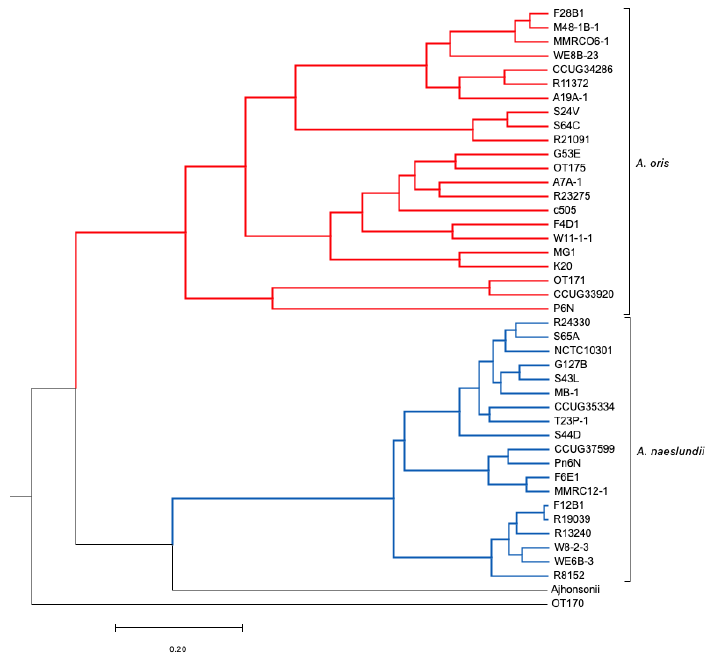
Figure 6. ClonalFrame consensus tree for 43 Actinomyces genomes using 476 Core genes. * Displayed in MEGA 3.1. The numbers are the bootstrap values.